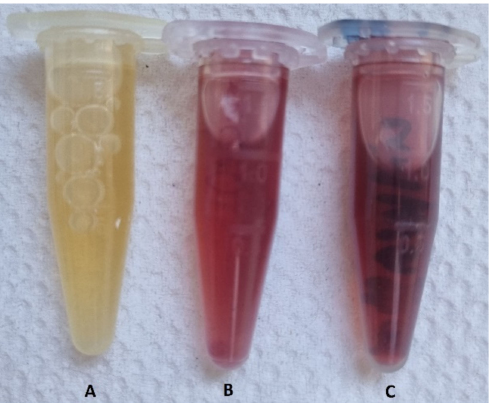
Figure 1. The changed color of the dispersions after incubation at two different “cold” and “hot” temperatures. ( A ) the negative control sample, ( B ) the sample incubated at 37 ◦ C (i.e., “cold”), and ( C ) the sample heated at 80 ◦ C (i.e., “hot”).